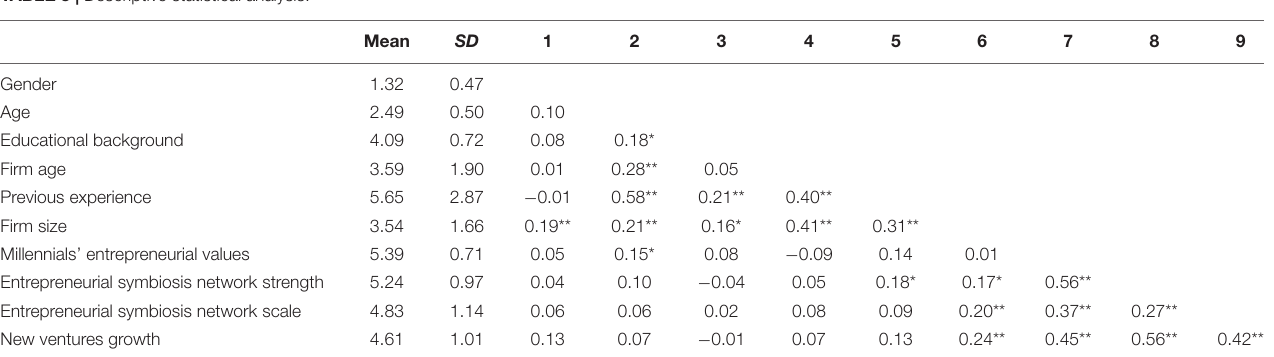
TABLE 3 | Descriptive statistical